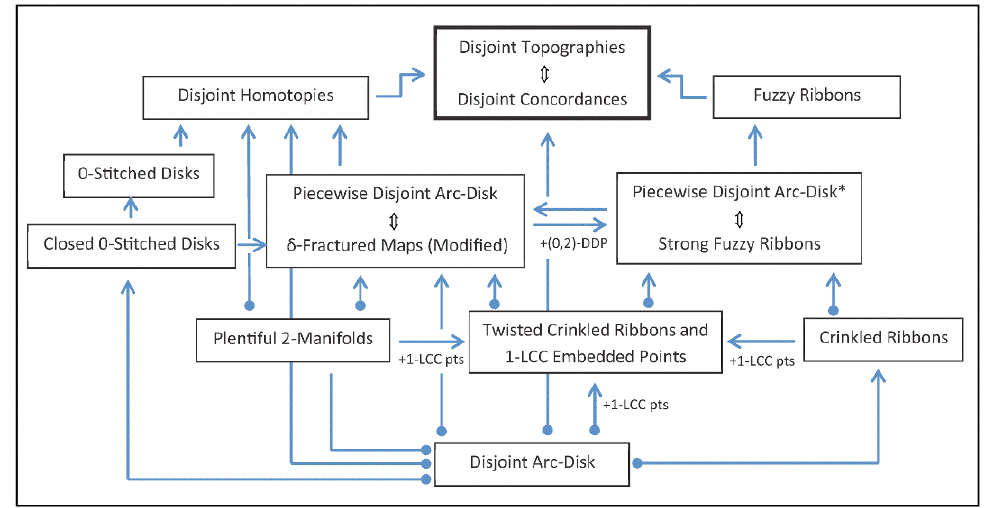
Figure 1. Relationships amongst general position properties that detect codimension one manifold